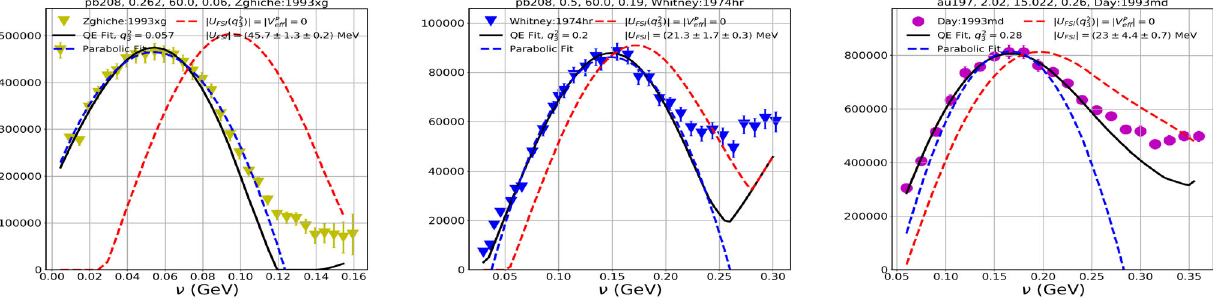
Fig. 15 Same as Fig. 8 for two of 22 208 Fig. 16 Extracted values of U FSI versus ( q 3 + k ) 2 for four Lithium ( 6 Li) 3